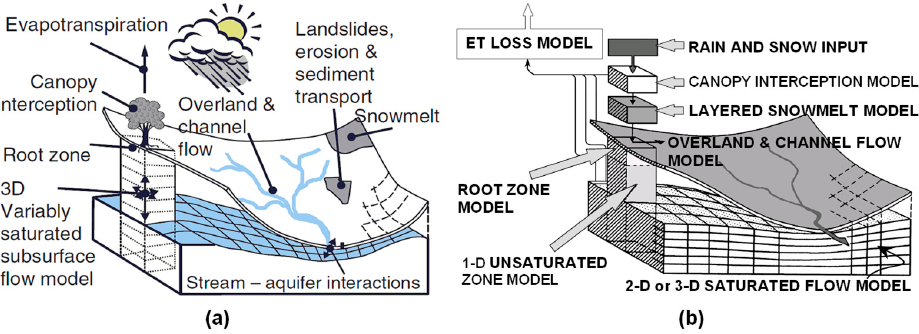
Figure 2. Schematic representation of the structure of the models ( a ) SHETRAN (after Bathurst , et al. [35]); and ( b ) MIKE SHE (after Vázquez and Feyen [36]). and ( b ) MIKE SHE (after V á zquez and Feyen